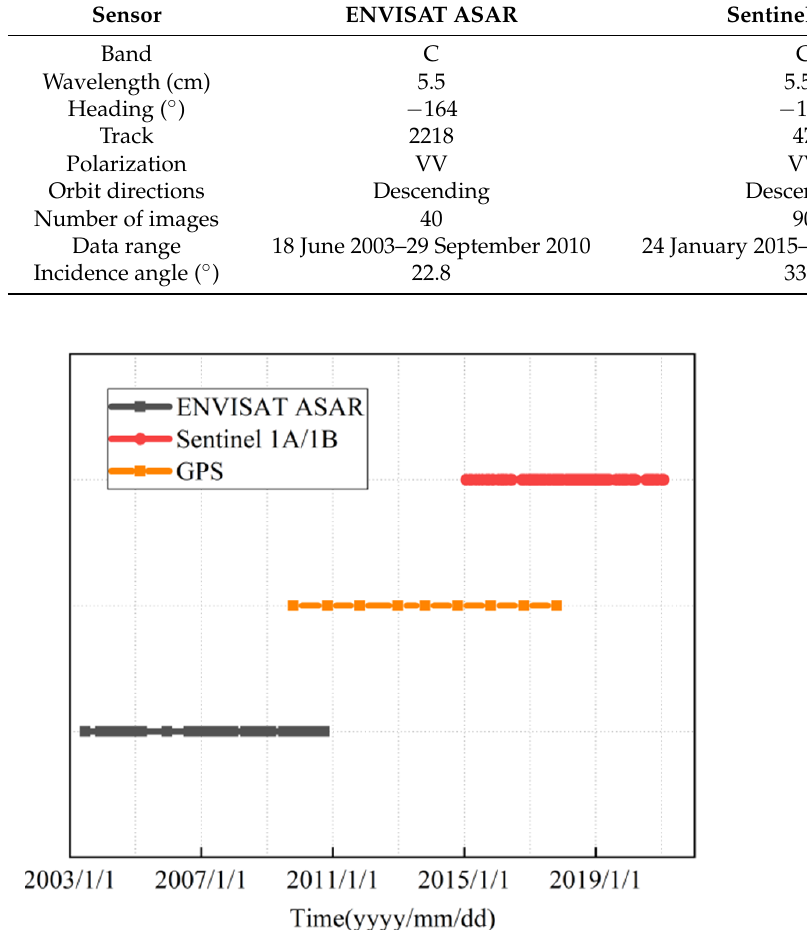
Figure 2. Time span of the SAR datasets and GPS measurement.